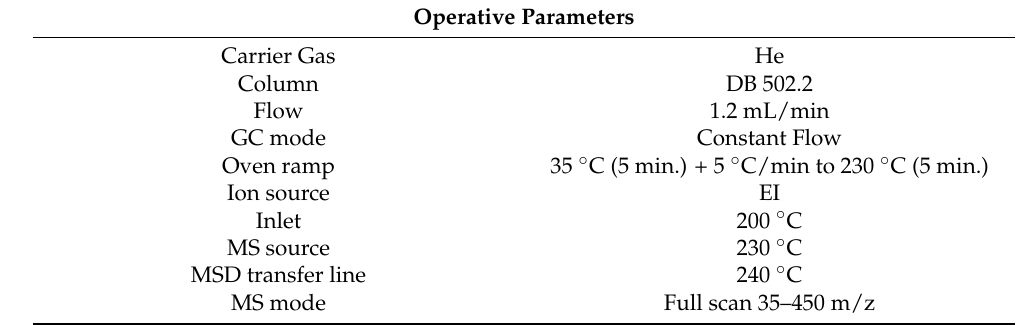
Table 2. Operative parameters optimized for VOC analysis.